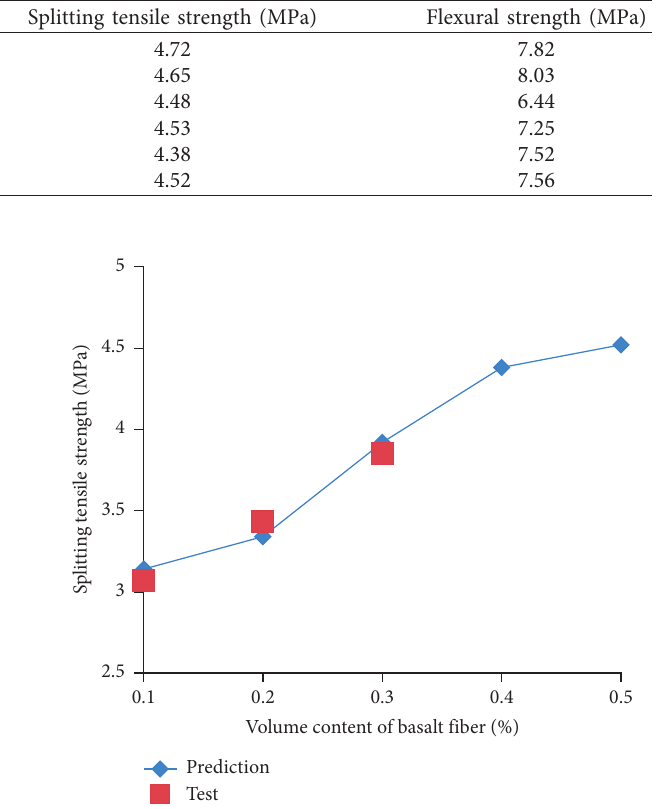
Figure 10: Variation of split tensile strength of